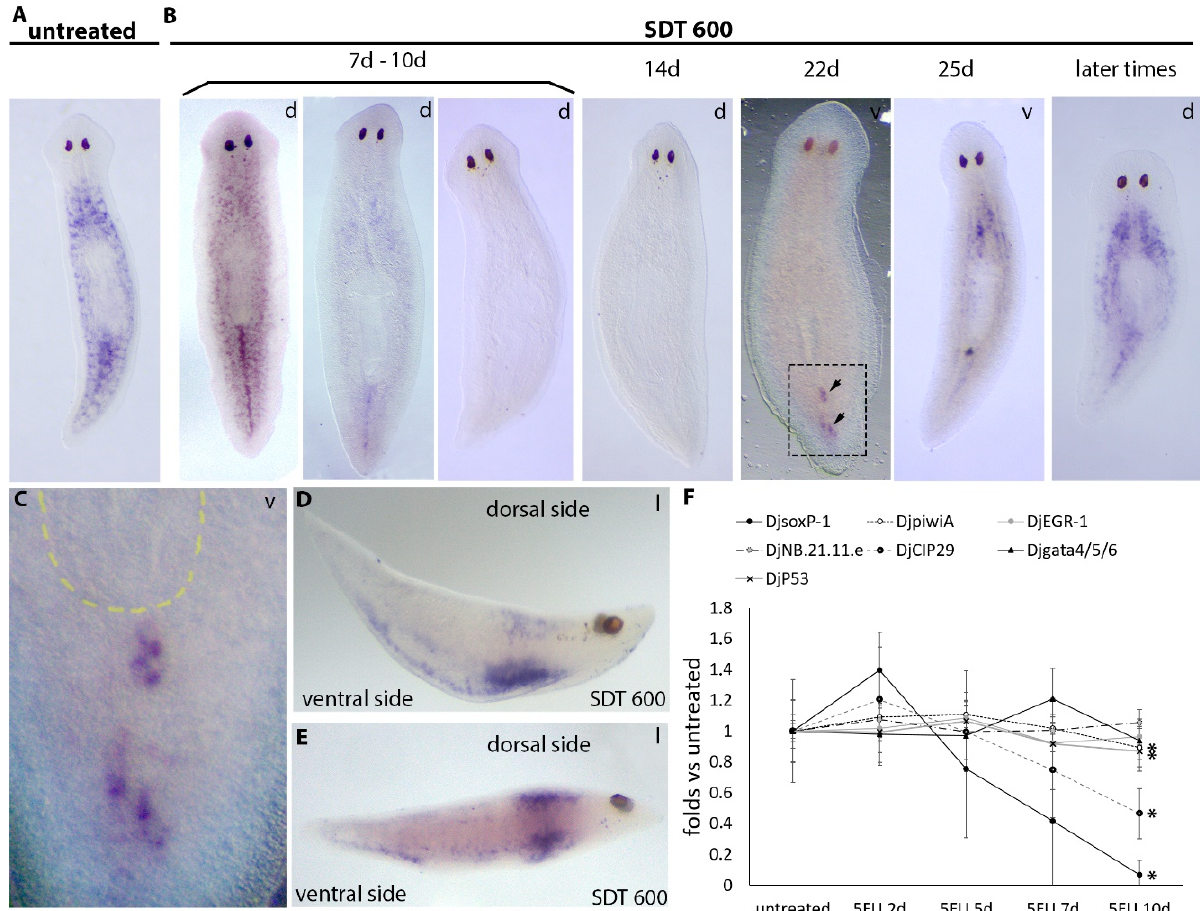
Figure 1. DjsoxP-1 expression visualized by whole-mount in situ hybridization in intact untreated controls and SDT-600 animals. ( A ) Representative image of DjsoxP-1 in situ hybridization in an untreated control. (d) Dorsal view. ( B ) Representative images of DjsoxP-1 in situ hybridization in 5FU-treated animals at different times after treatment. Different images are shown for the temporal window between 7 and 10 days to represent the inter-experimental variability. Arrows indicate the most limited expression found for DjsoxP-1 in SDT-600 animals 22 days after treatment. (d) Dorsal view; (v) ventral view. ( C ) Magnification of the boxed region of an SDT-600 animal 22 days after treatment shown in ( B ). (v) Ventral view. Yellow dashed line indicates the pharynx. ( D , E ) Lateral view (l) of some representative animals sacrificed at later times after SDT-600 treatment and hybridized with DjsoxP-1 . The two animals showed different levels of repopulation of the dorsal side. Scale bar corresponds to 400 µ m in ( A , B ), 80 µ m in ( C ), and 200 µ m in ( D , E ). ( F ) Graph depicting densitometry analysis of hybridized animals at different time points during the first 10 days of treatments. Each point is the mean value ± SD of the data obtained in at least two different experimental replicates of normalized versus untreated controls, in which the arbitrary value of 1 has been attributed. The high SD of the DjsoxP-1 value 7 days after treatment is attributable to inter-experimental differences in the time at which the expression of this transcript starts to decrease. Statistically significant differences (* p < 0.05) are indicated only for time points at which they have been verified in all the experimental sets; only DjsoxP-1 , DjpiwiA , DjCIP29 , and DjP53 showed statistically significant